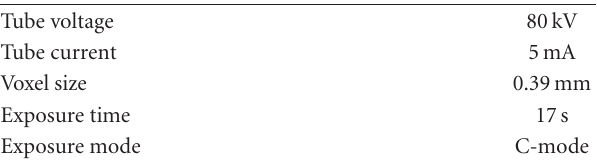
Table 1: Present exposure